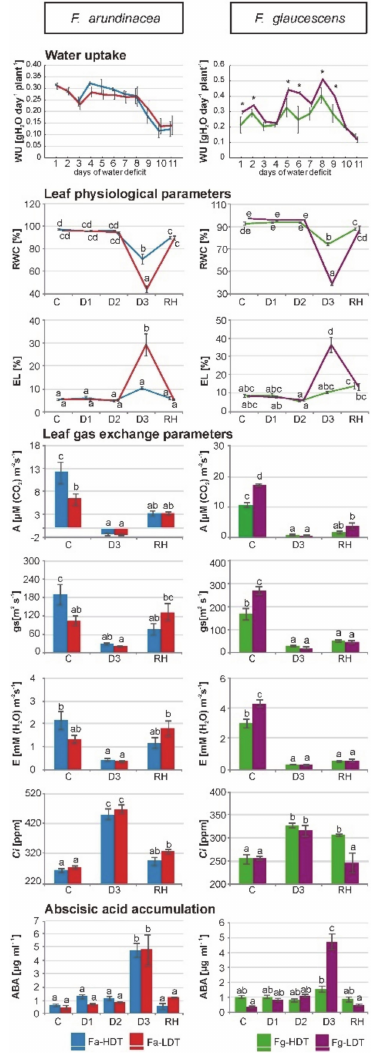
Figure 1. The water uptake ( WU ), relative water content ( RWC ), electrolyte leakage ( EL ), gas exchange parameters (CO 2 assimilation ( A ), stomatal conductance ( g s ), transpiration ( E ), intracellular concentration of CO 2 ( Ci )) and accumulation of abscisic acid ( ABA ) in two genotypes of F. arundinacea (Fa-high drought tolerant (HDT), Fa-low drought tolerant (LDT)) and F. glaucescens (Fg-high drought tolerant (HDT), Fg-low drought tolerant (LDT)) during all water deficit or at di ff erent time-points: before stress treatment (C), on the 3rd (D1), 6th (D2), and 11th (D3) day of water deficit and 10 days after re-hydration initiation (RH). Error bars represent the standard errors (SE). Homogeneity groups are denoted by the same letters, according to Fischer LSD test ( p = 0.01). Asterisks indicate di ff erences between genotypes according to the student t-test ( p =